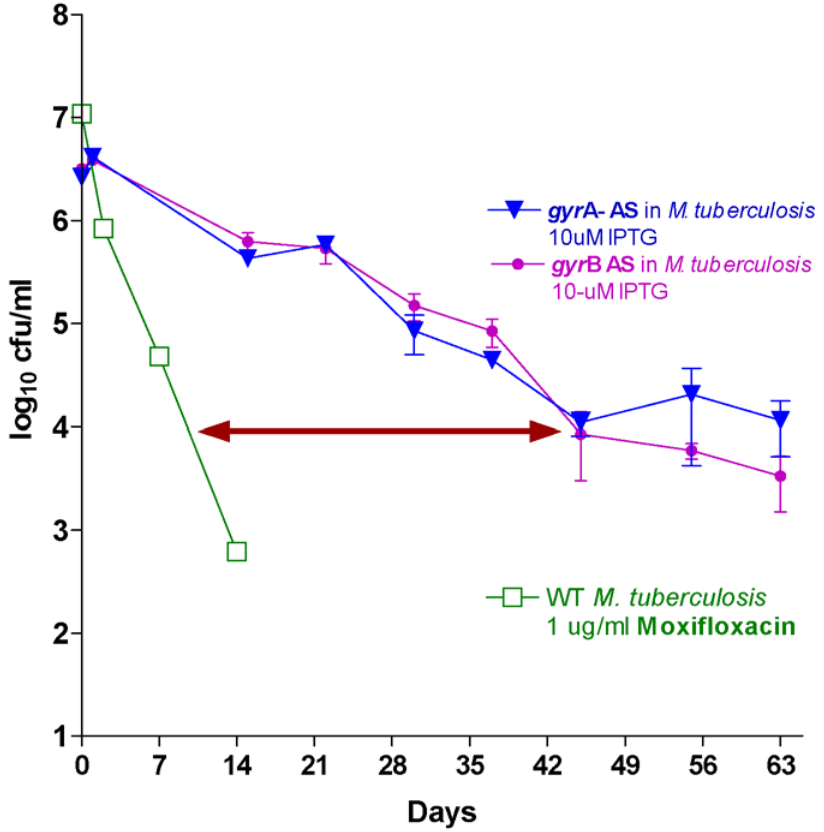
Figure 8. Survival kinetics of M.tuberculosis (with M.tuberculosisgyr A-AS and gyrB -AS plasmids individually). Induction at 10 uM IPTG. gyr A-AS is bactericidal whereas gyrB -AS is showing no-effect due to an extra copy of gyr B gene (orphan gyr B). Survival kinetics of wild type M. tuberculosis upon exposure to 1 ug/ml conc. of Moxifloxacin is cidal.